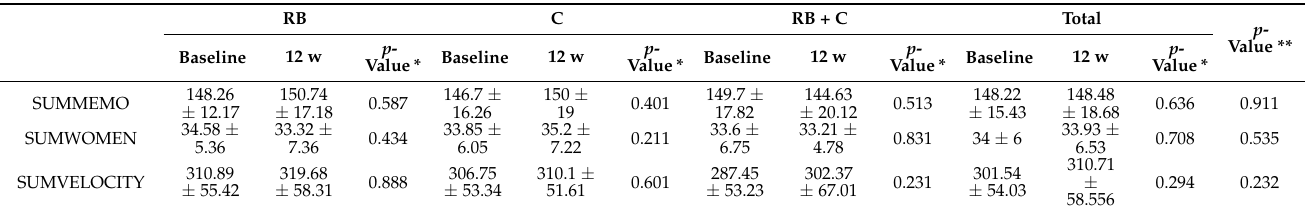
Table 7. Statistical results of the different summatives for each test in each group and by visit.